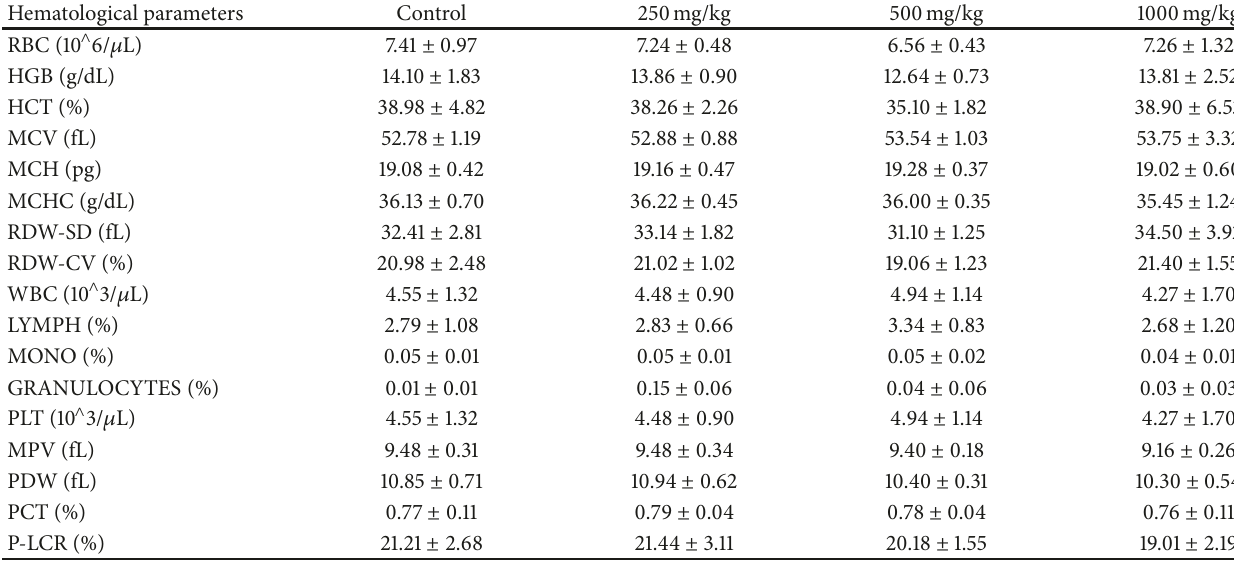
Table 4: The effects of different concentrations methanolic extract of pomelo on the hematological parameters of whole blood. Hematological parameters Control